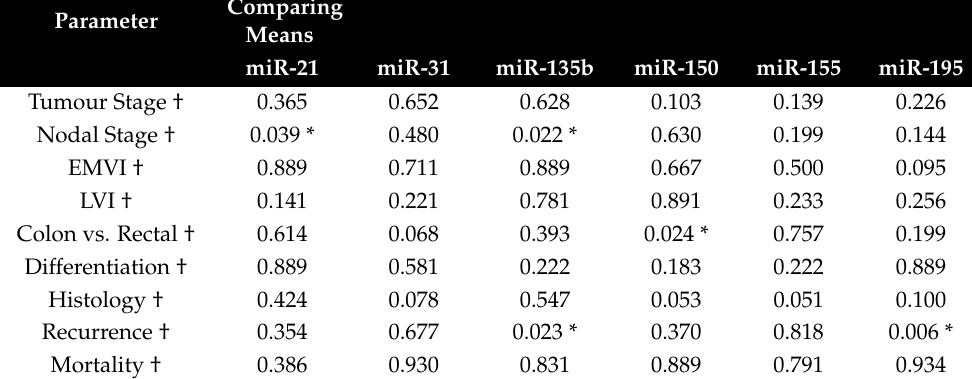
Table 3. Correlation of miRNA expression profiled with clinicopathological, recurrence, and sur- vival data.